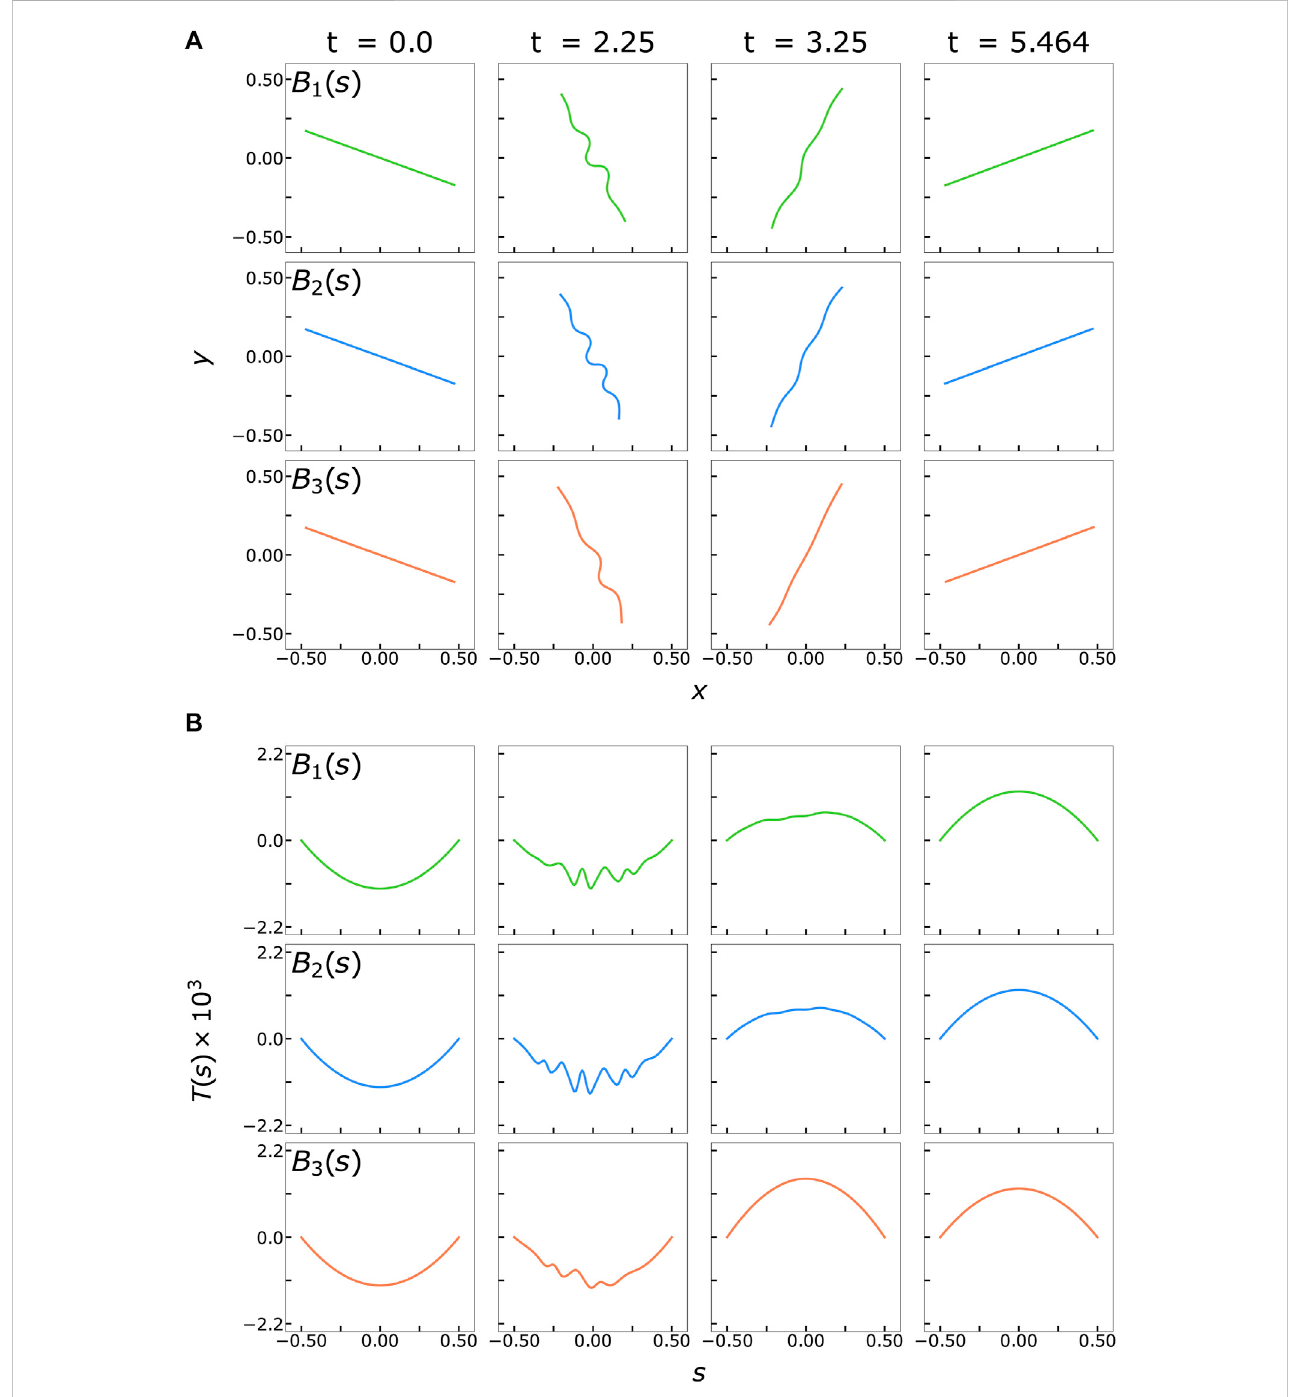
FIGURE 2 (A) Snapshots of fi lament buckling behavior in non-Brownian shear fl ow at various time points based on the three different rigidity pro fi les, all for fl ow strength (cid:2) μ (cid:1) 5 × 10 5 (B) The fi lament tension pro fi le at the same timepoints as a function of the arclength s